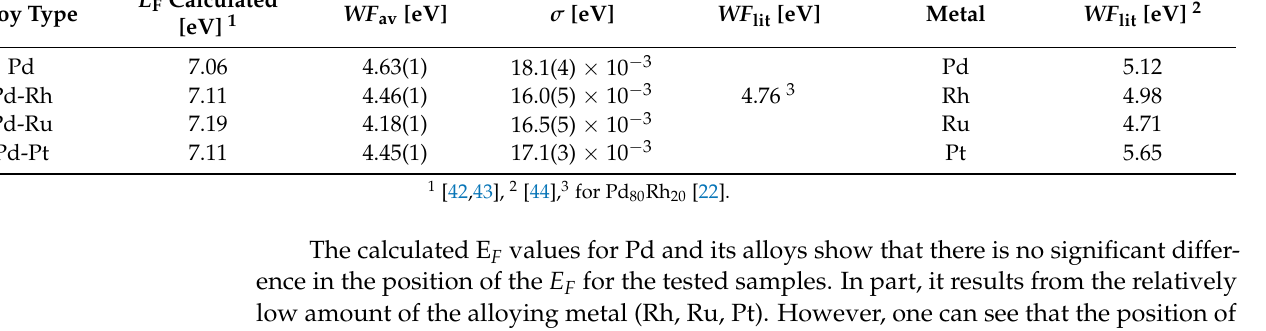
Figure 4. Distribution histogram of work function corresponding to Figure 3 for as-deposited electrodes: ( a ) Pd; ( b ) Pd-Rh; ( c ) Pd-Ru; ( d ) Pd-Pt. Continuous red lines represent fits obtained using the Gaussian function.